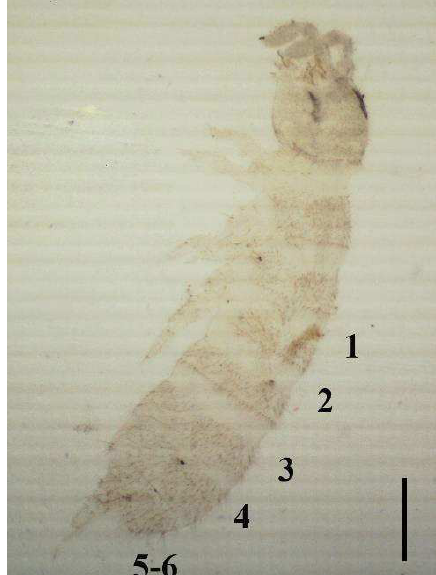
F IGURE 18 . Abdomen 5 and 6 fused in Hemisotoma (scale: 500 µm) .